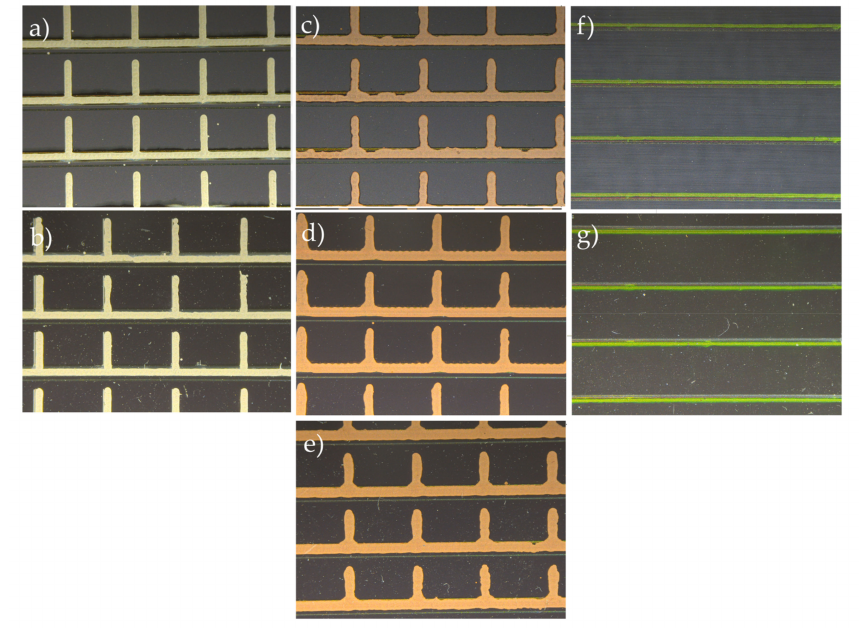
Figure 4. Material demonstrators: ( a ) Ag grid, AZO as front contact; ( b ) Ag/AZO, coated with silicate-based Sol-gel; ( c ) Cu grid, AZO as front contact; ( d ) Cu/AZO, coated with a silicate-based Sol-gel; ( e ) Cu/AZO, coated with CAG37; ( f ) no grid, ITO as front contact; ( g ) ITO, coated with a silicate-based